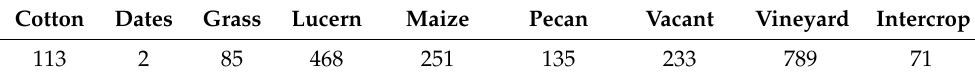
Table 1. Number of fields for each crop after preprocessing of Farmpin dataset.